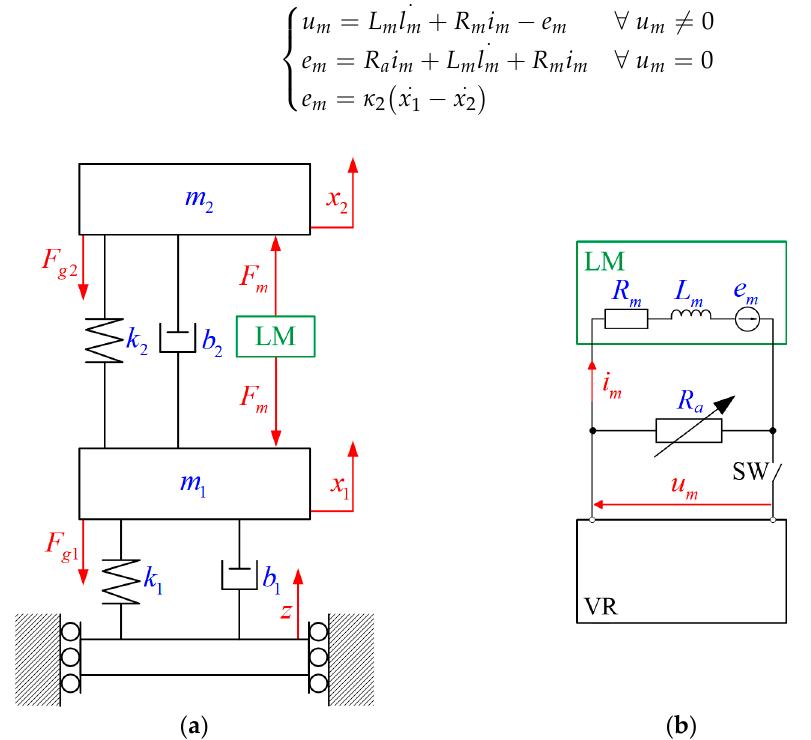
Figure 1. Diagram of the HVRS: ( a ) mechanical subsystem; ( b ) electrical subsystem.